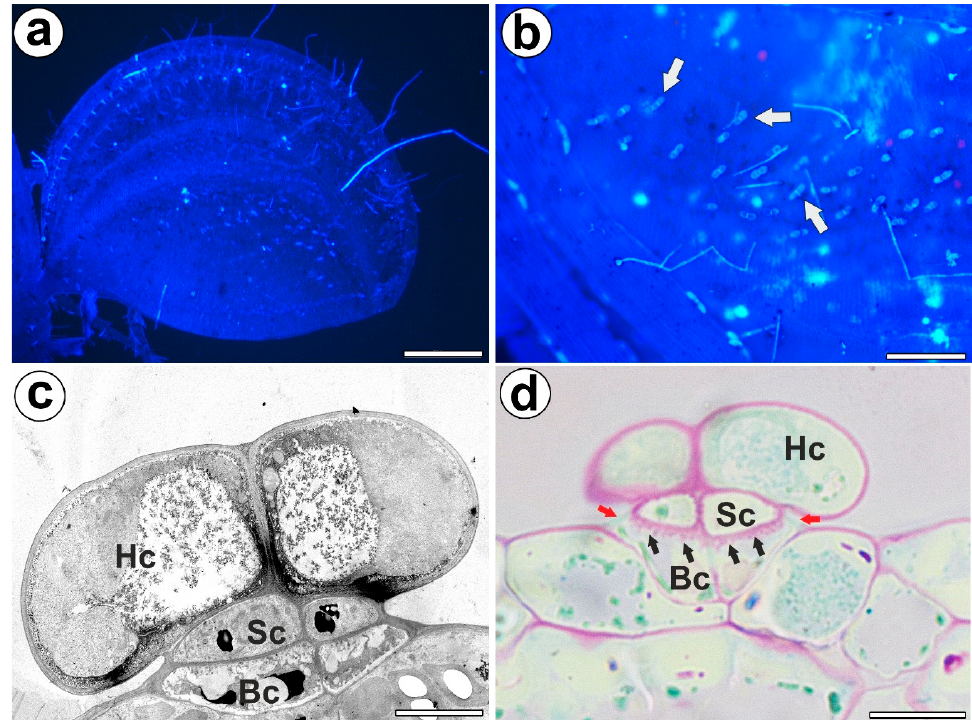
Figure 1. Distribution, morphology, and structure of the bifid trichomes of the Aldrovanda vesiculosa traps. ( a ) Aldrovanda vesiculosa trap, bar 500 µm. ( b ) Bifid trichomes on the external surface of a trap (arrow), bar 100 µm. ( c ) Ultrastructure of a bifid trichome; head cell (Hc), stalk cell (Sc), basal cell (Bc), bar 500 nm. ( d ) Positive result of the PAS reaction of the cell wall ingrowths (black arrows); head cell (Hc), stalk cell (Sc), basal cell (Bc), Casparian strip (red arrows), bar 10 µm.